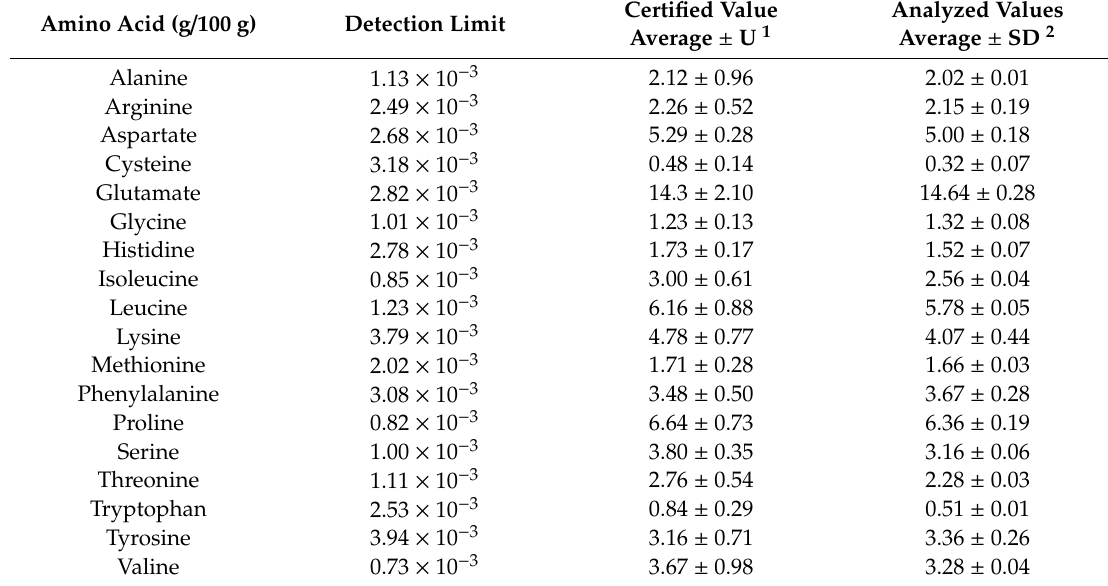
Table 2. Quality assurance of amino acids analysis (acid hydrolysis under anaerobic conditions followed by liquid chromatography (UPLC)) using a certified reference material NIST 3244 * ( n = 3). Amino Acid (g / 100